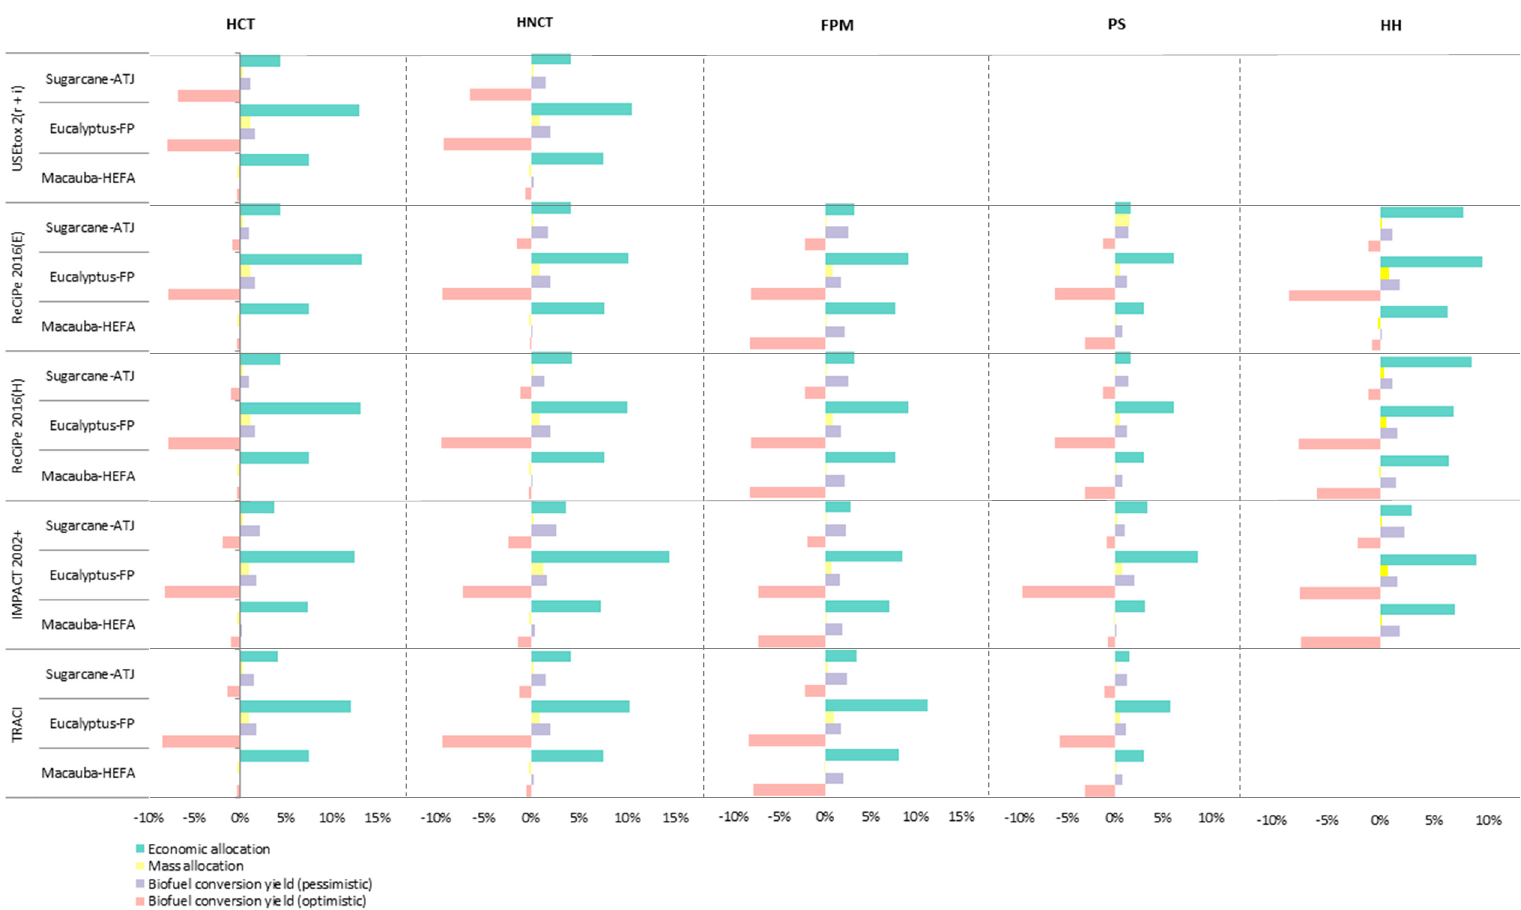
Figure 5. Sensitivity analysis on the allocation method (i.e., economic allocation and mass allocation) and biofuel conversion yield (i.e., pessimistic and optimistic), expressed in change in %, using energy allocation as the base case.